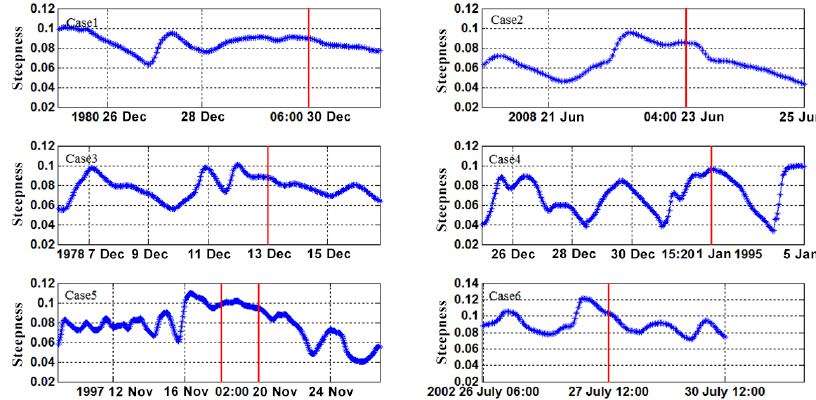
Figure 2. Time series of simulated wave steepness (cases 1–6), red lines refer to the freak waves occurrence time.